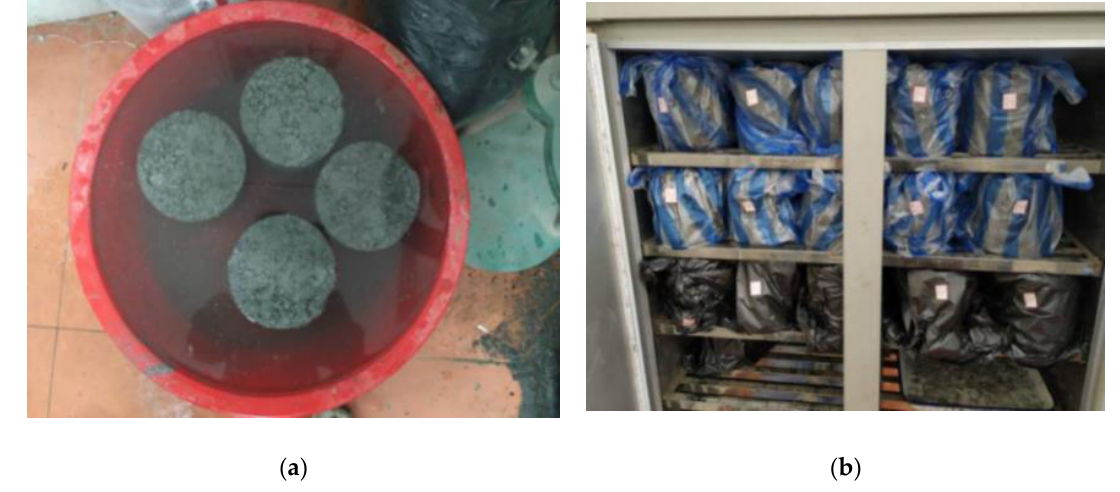
Figure 5. Shrinkage test: ( a ) water immersion; ( b ) temperature-controlled cabinet.